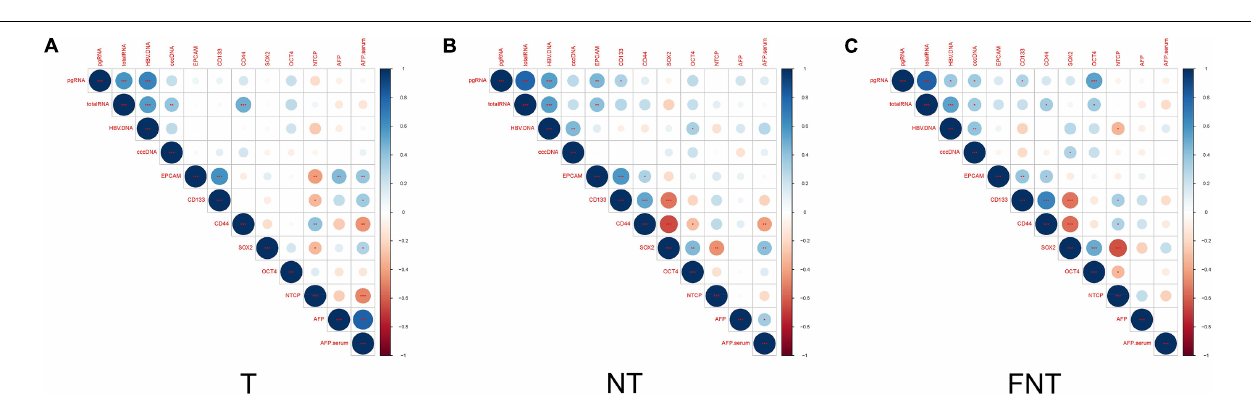
p = 0.033), tumor size (HR = 5.423, p = 0.008),